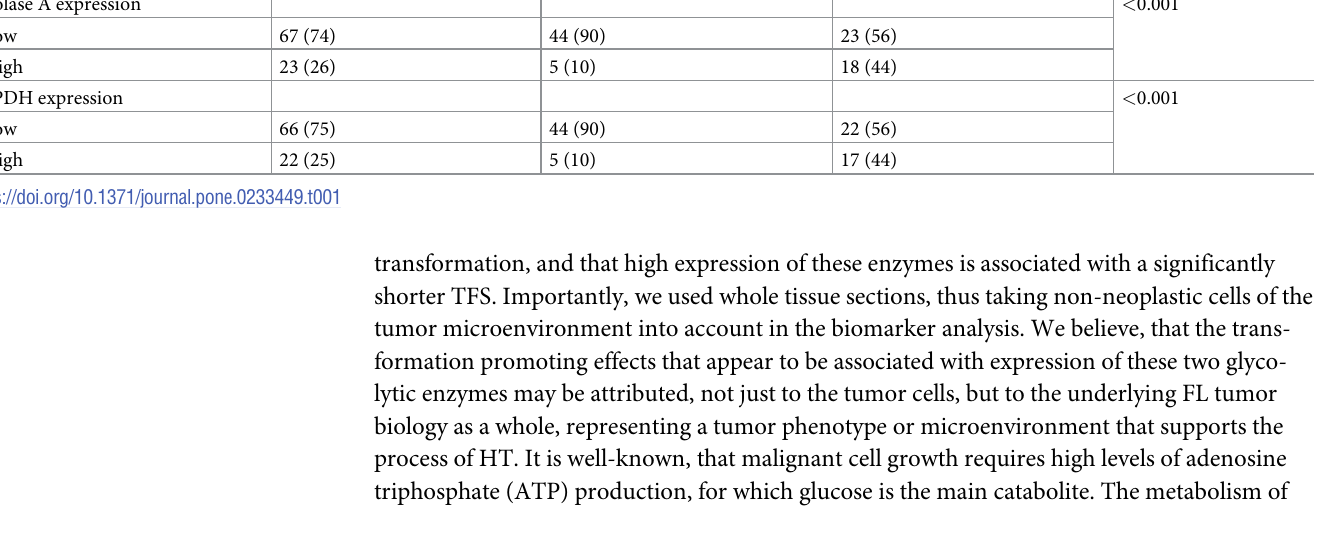
PLOS ONE | https://doi.org/10.1371/journal.pone.0233449 May 22,